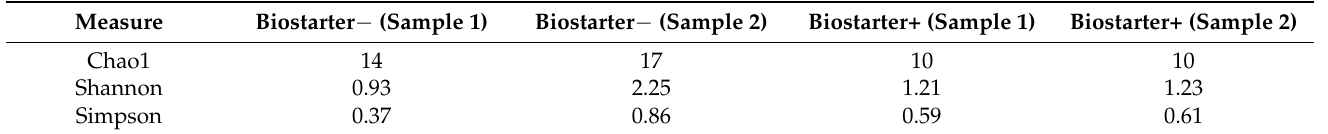
Table 3. The alpha-diversity indices (Shannon, Chao1, and Simpson) of the bacterial communities after 28 d of aging with and without biostarter.